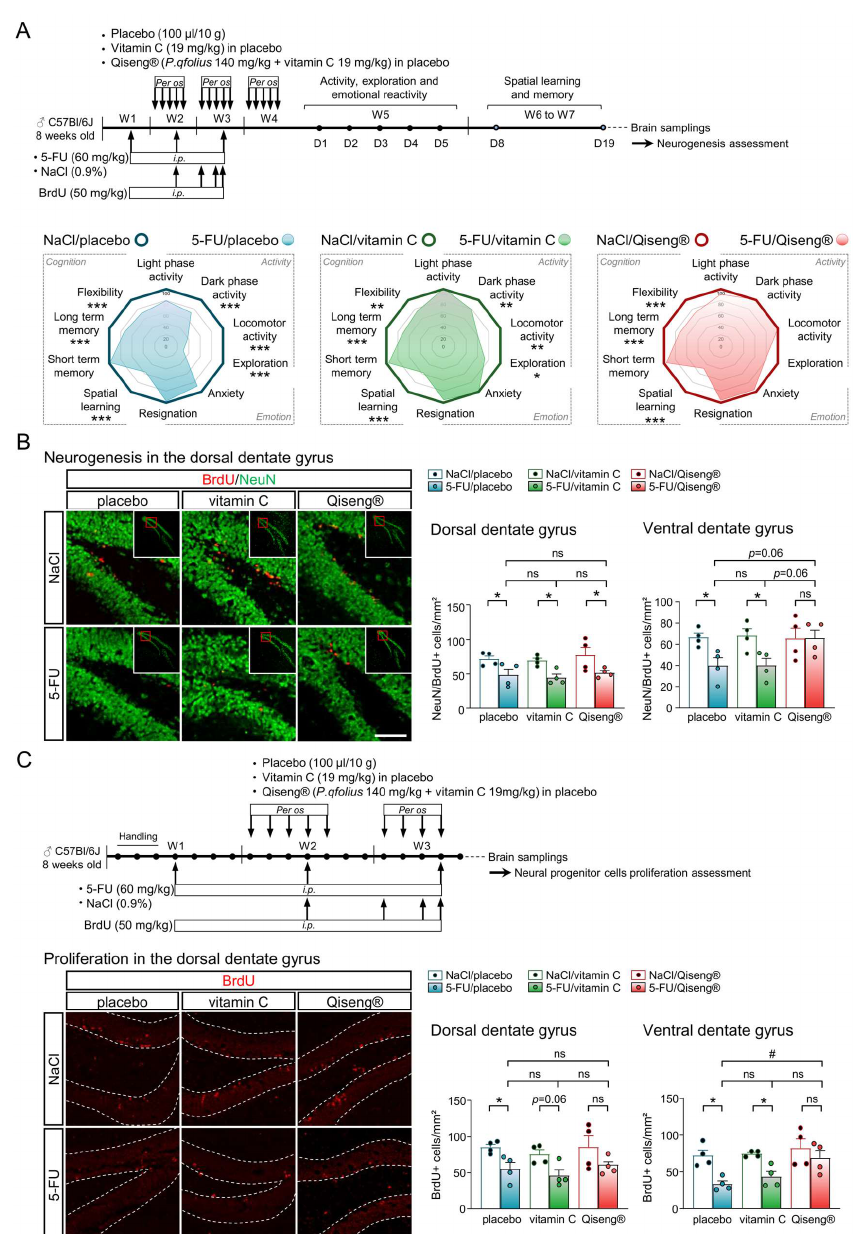
Figure 3. Preventive effect of Qiseng ® on 5-FU-induced altered activity and exploration and de- creased precursor proliferation and neurogenesis in ventral and dorsal hippocampus. ( A ) Schematic representation of the schedule and experimental protocol showing the timeline for treatments and behavior experiments (see Figures 1 and 2). C57BL/6J Rj mice received one injection of 5-FU once a week for 3 weeks (i.p., arrow ) and per os administration of placebo solution, vitamin C (19 mg/kg)